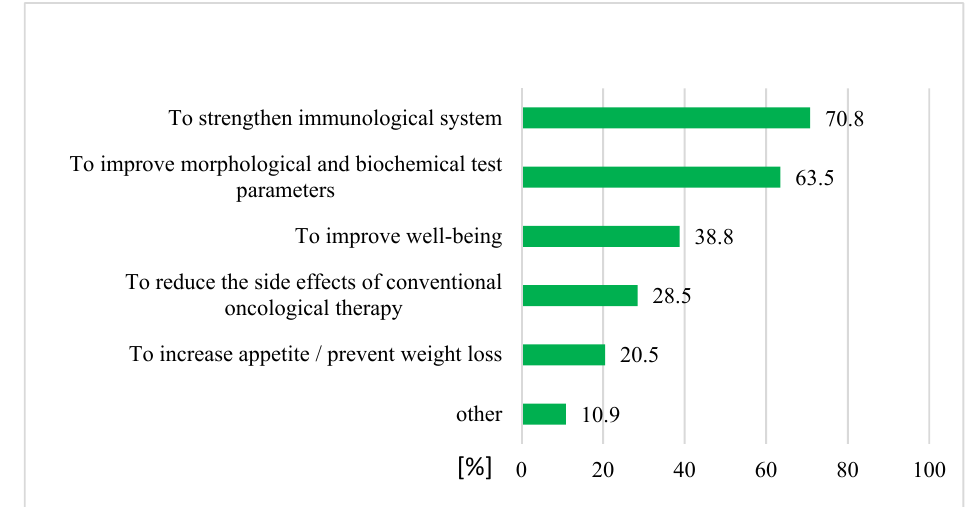
Figure 4. Reasons for CAM use as a complementary medicine (n = 312).